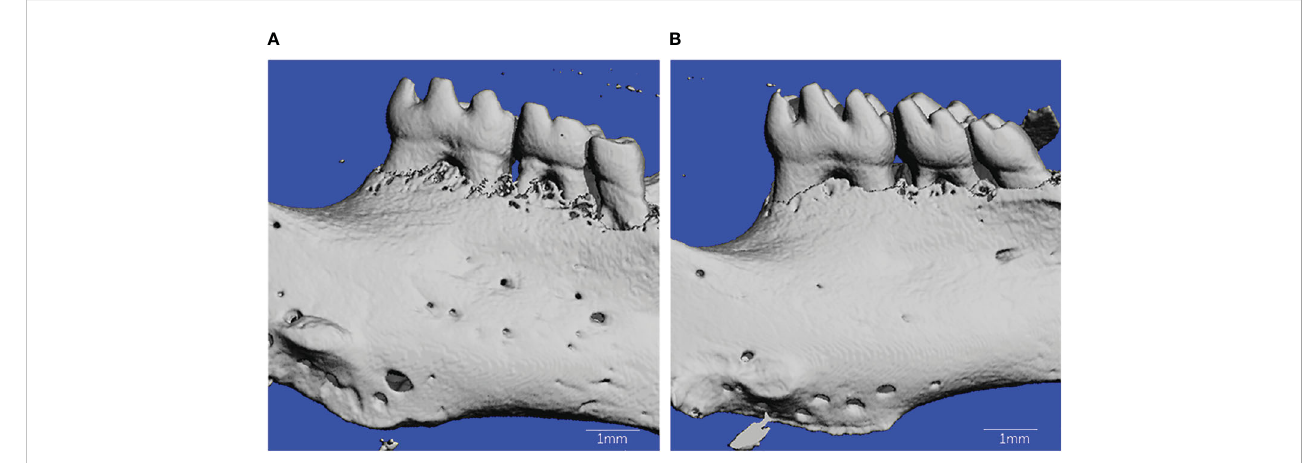
FIGURE 2 Microcomputed tomography reconstruction of mandibles in T1DM and control mice. (A) is from T1DM mice, and (B) is from control